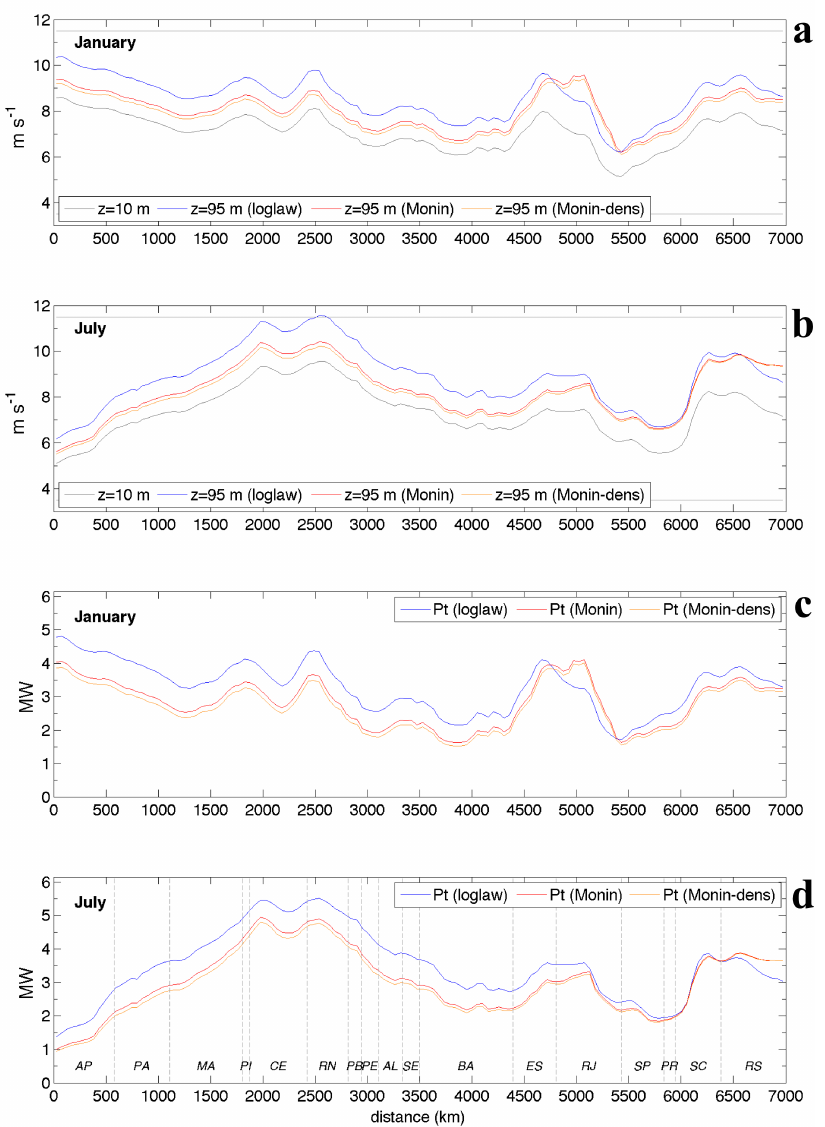
Figure 7. Along-coast variability of wind speed and turbine power. The x-axis represents the distance (km) along the Brazilian coast, from its northern limit at Amapá (AP, left) to its southern end at Rio Grande do Sul (RS, right). Panels ( a , b ) are wind magnitudes at z = 10 m and at the hub height ( z = 95 m), computed with three different methods for January and July, respectively. Panels ( c , d ) are power distributions estimated from SE 6.2 power curve and three methods for January and July, respectively. Labels refer to the logarithmic extrapolation method (log-law, U l ), the Monin–Obukhov (Monin, U m ) and Monin–Obukhov with density correction (Monin-dens, U c ). All quantities were averaged along the sectors shown in Figure 1 up to depths of 100 m. States names are listed in the legend of Figure